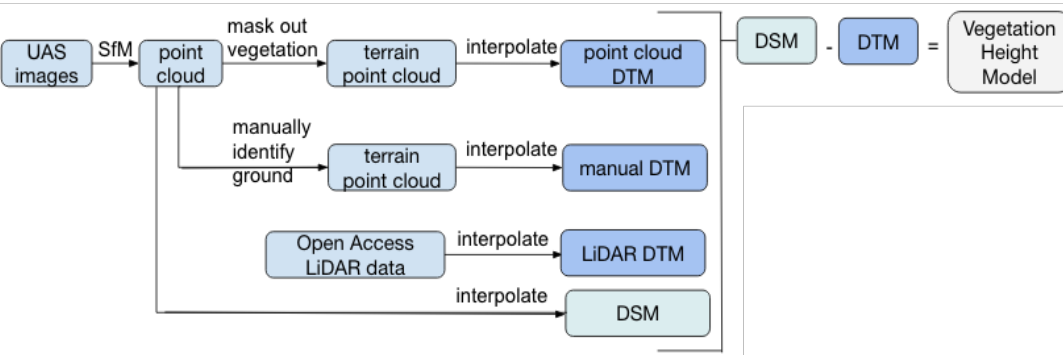
Figure 3. Schematic describing the process of deriving three Digital Terrain Models (DTMs) and one Digital Surface Model (DSM) to generate a vegetation height